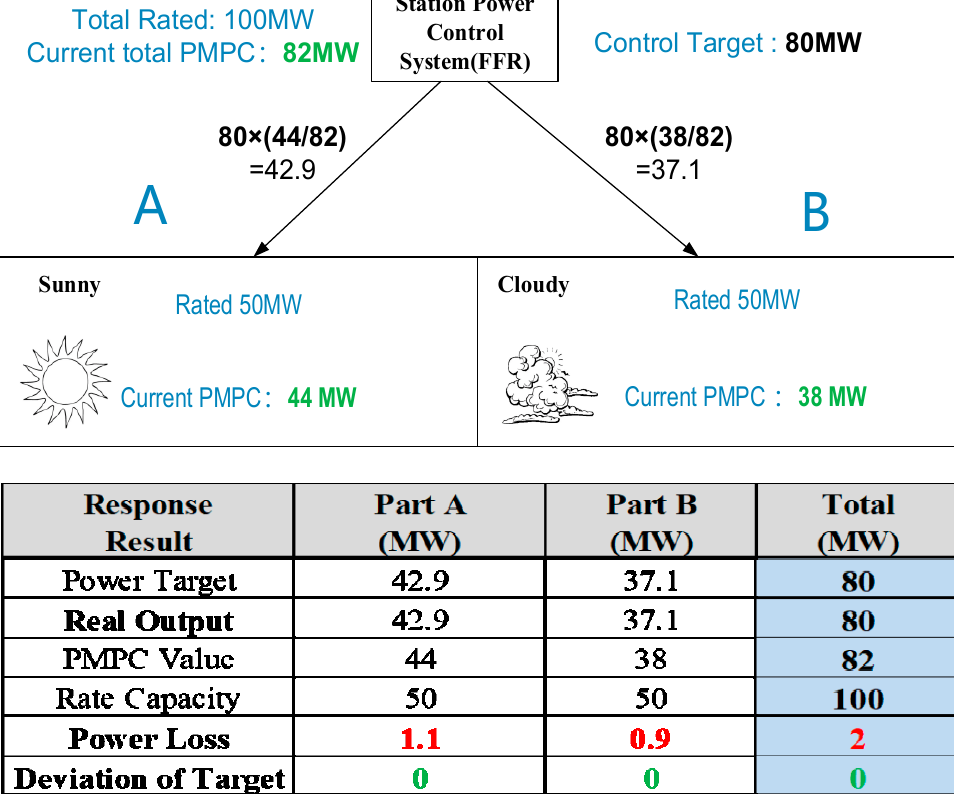
Figure 3. Power distribution effect of real-time proportional algorithm.